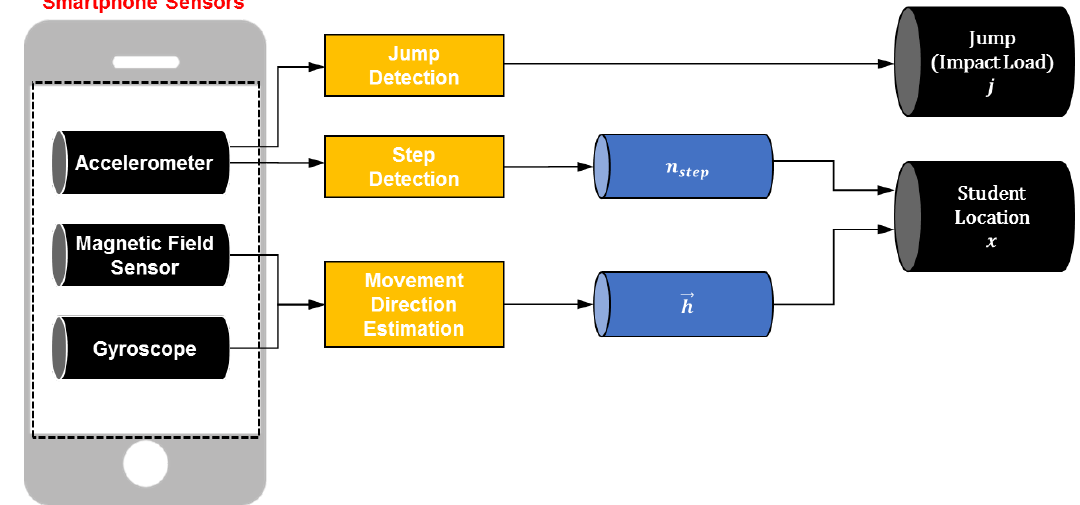
Figure 4. Overview of motion sensing using smartphones.